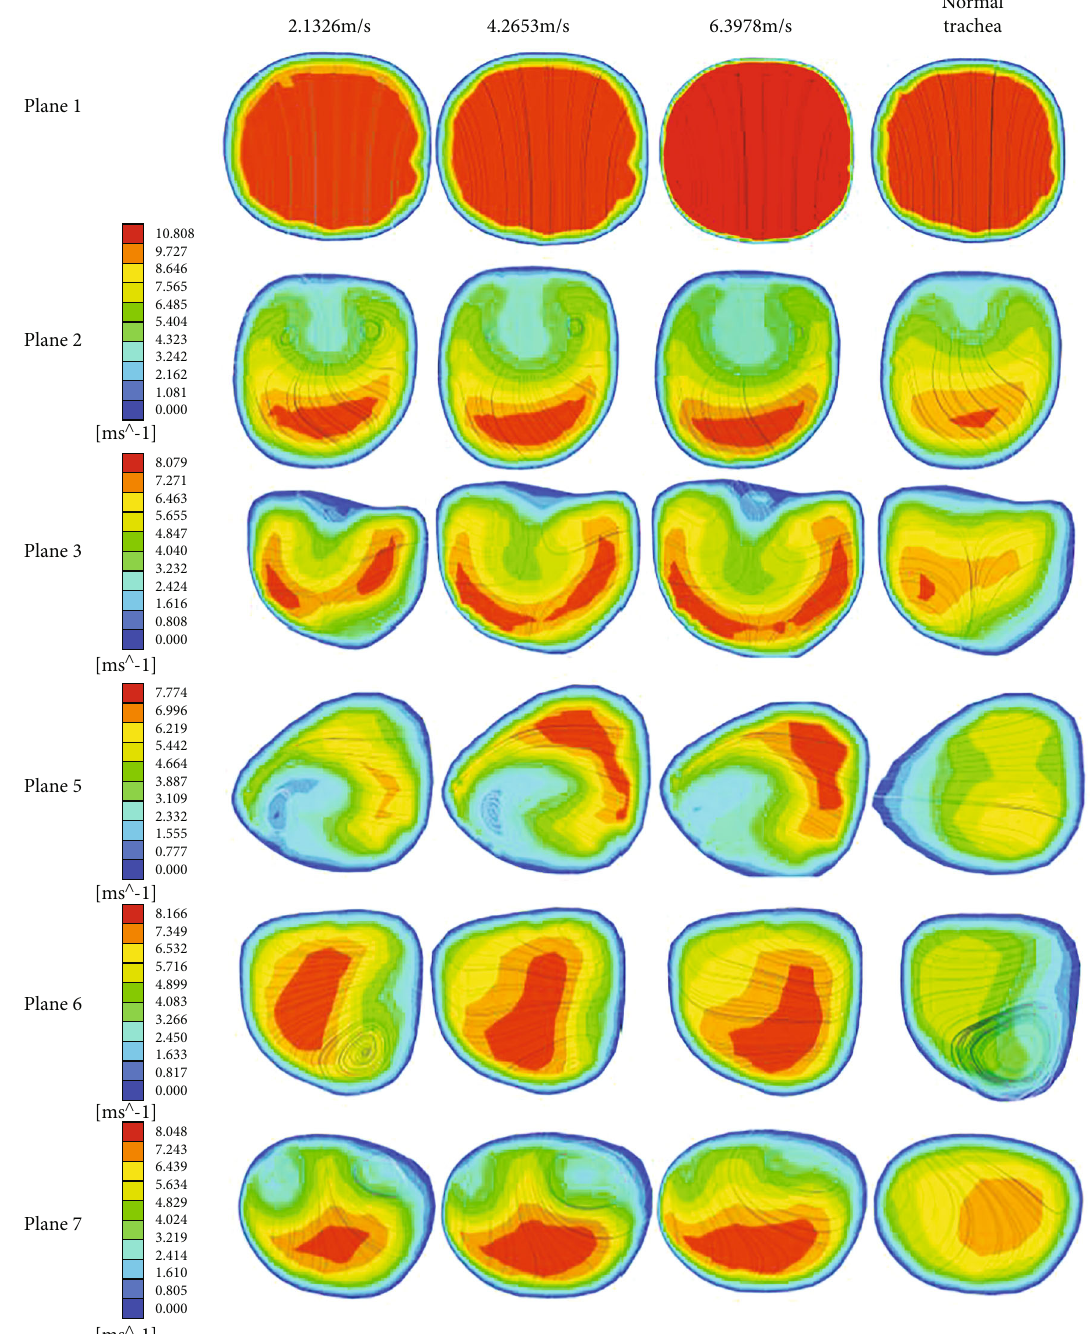
Figure 5: Velocity contours at di ff erent positions for three di ff erent air fl ows